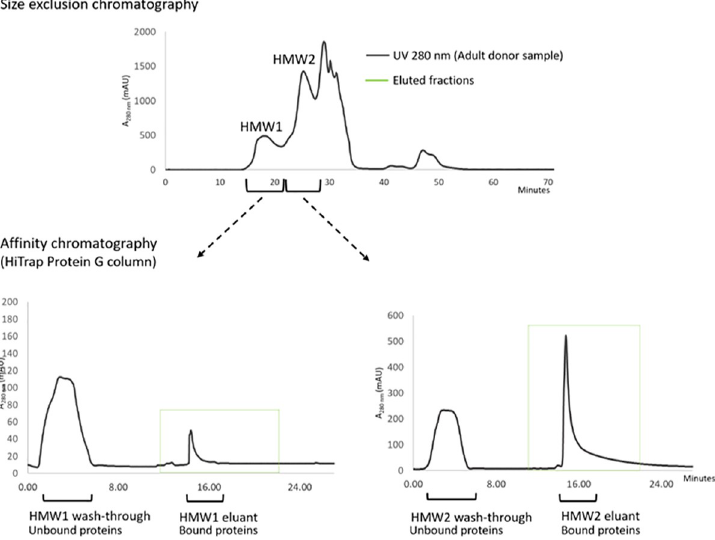
Fig 2. Experimental workflow used to recover and purify each peak from the affinity purification step prior to protein sequencing.